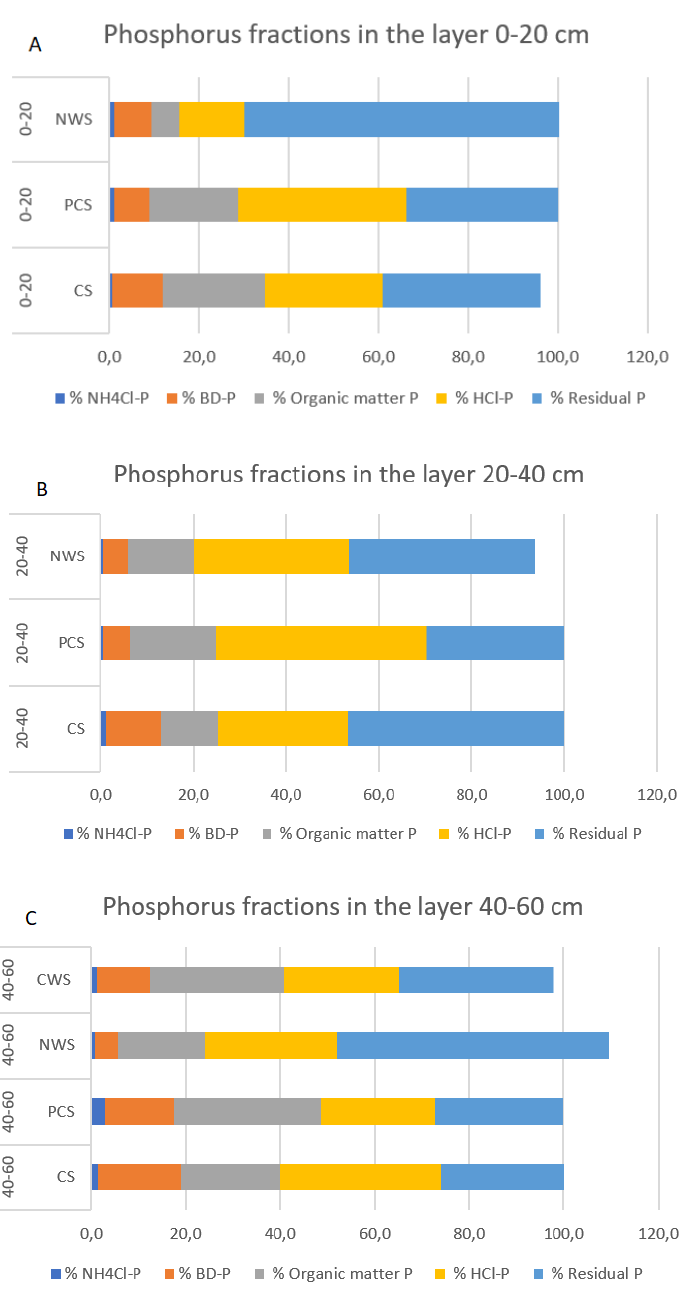
Figure 3. Phosphorus fractions for different soil layers and management. ( A ) Phosphorus fractions in the 0–20 cm layer; ( B ) phosphorus fractions in the 20–40 cm layer; ( C ) phosphorus fractions in the 40–60 cm layer.